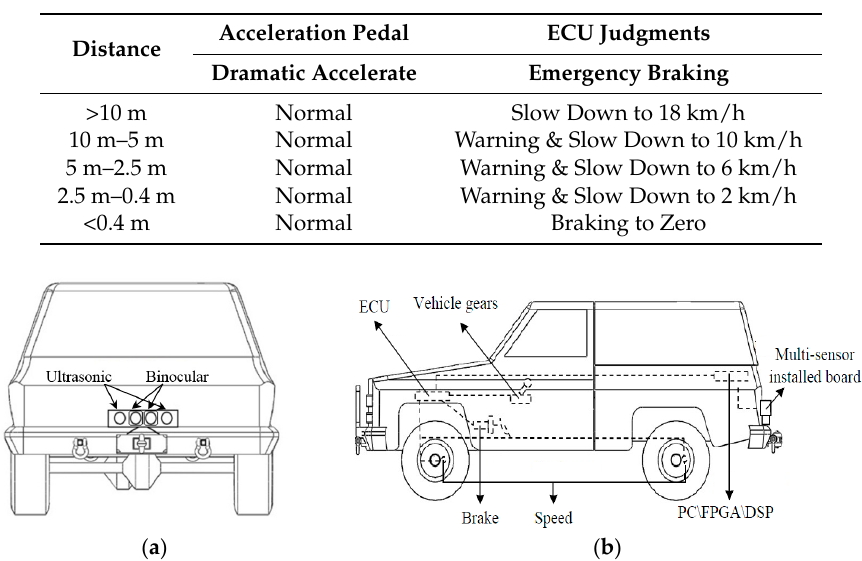
Figure 11. Vehicle reversing speed control prototype: ( a ) position of multi-sensors; ( b ) prototype of the vehicle reversing speed control system.